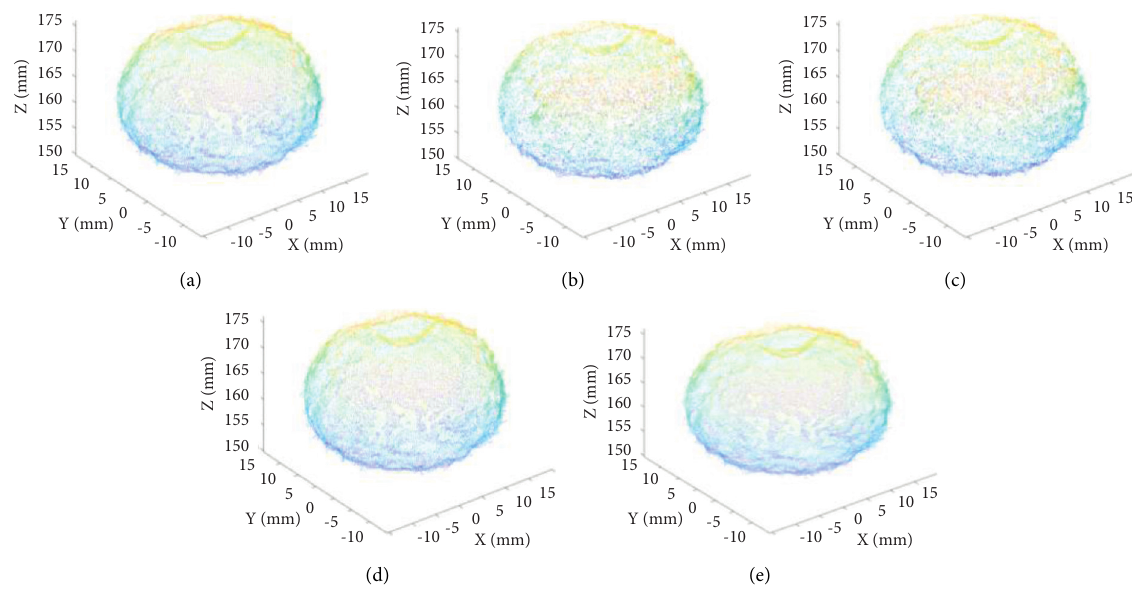
Figure 8: Simplification effect of different sampling methods. (a) 3D voxel grid filter; (b) curvature sampling; (c) random sampling; (d) uniform sampling; (e) distance